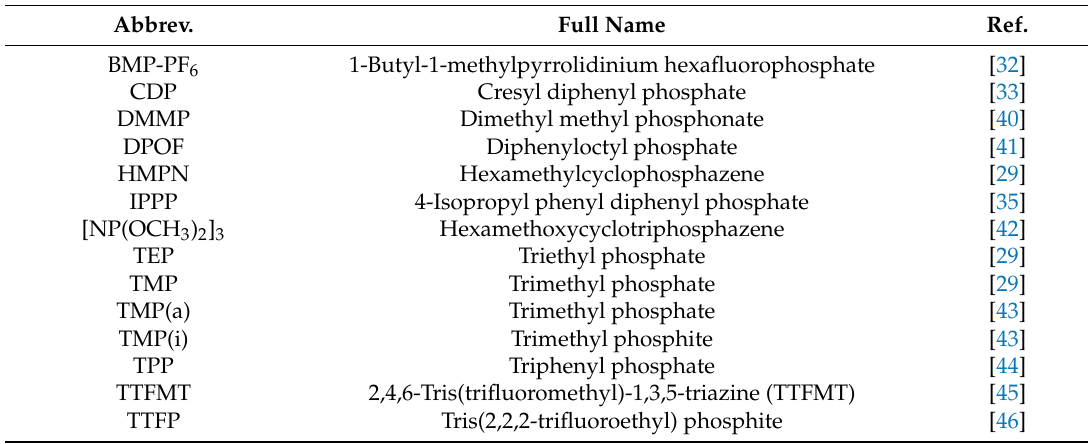
Table 1. Some flame retardants from published research work.